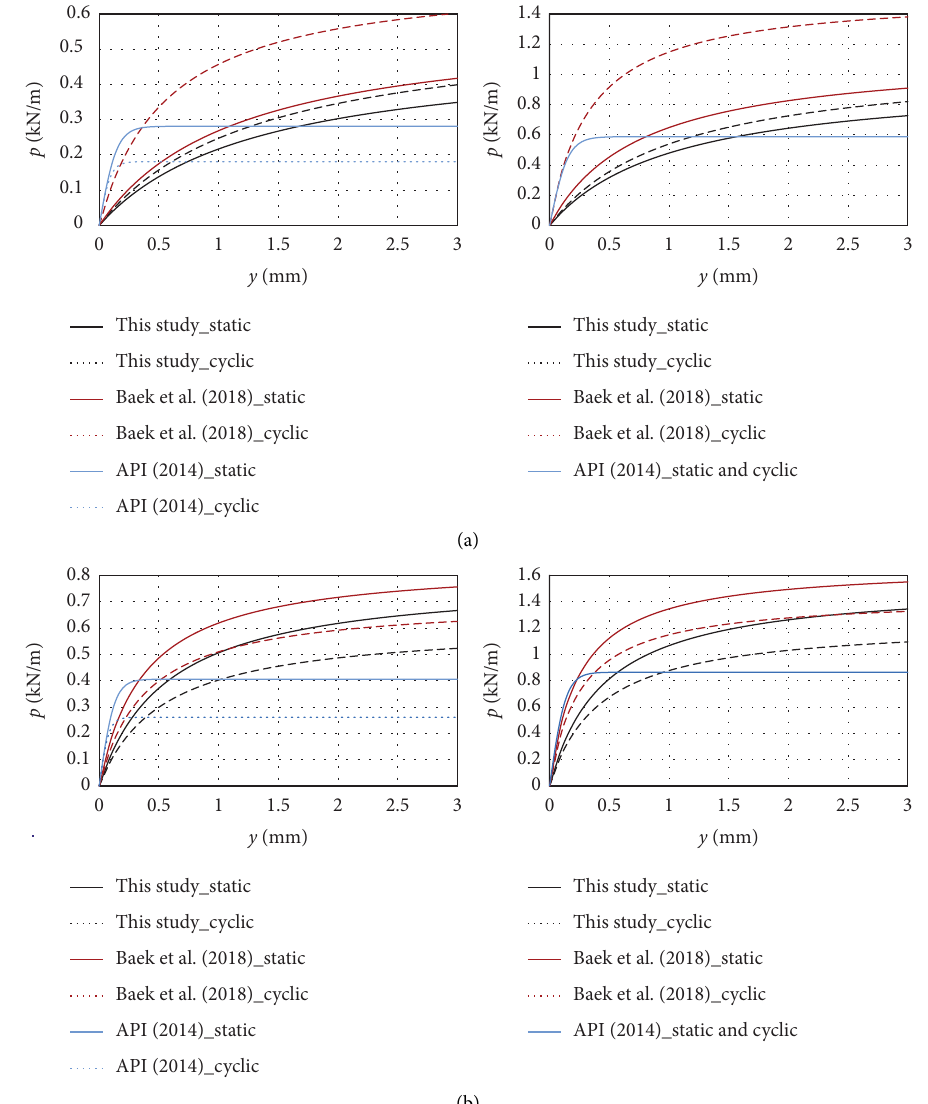
Figure 13: Proposed cyclic p - y curves and existing p - y curves for sandy soils at depths of 2 D (left) and 4 D (right). (a) 40%. (b) 70%.